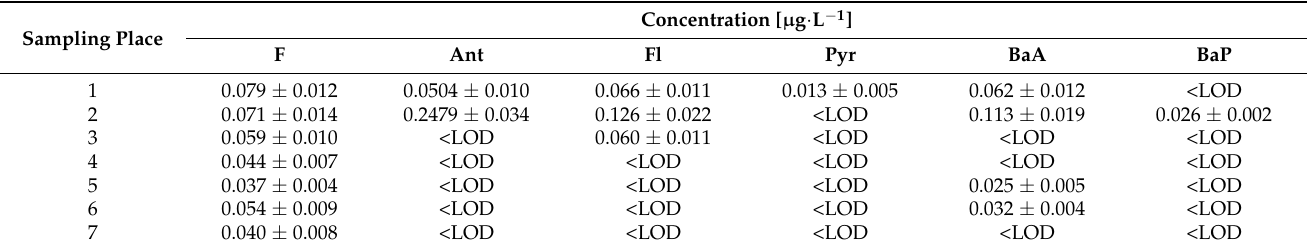
Table 4. Concentrations of selected PAHs in hoarfrost deposited across Wielkopolska district, Poland. Sampling